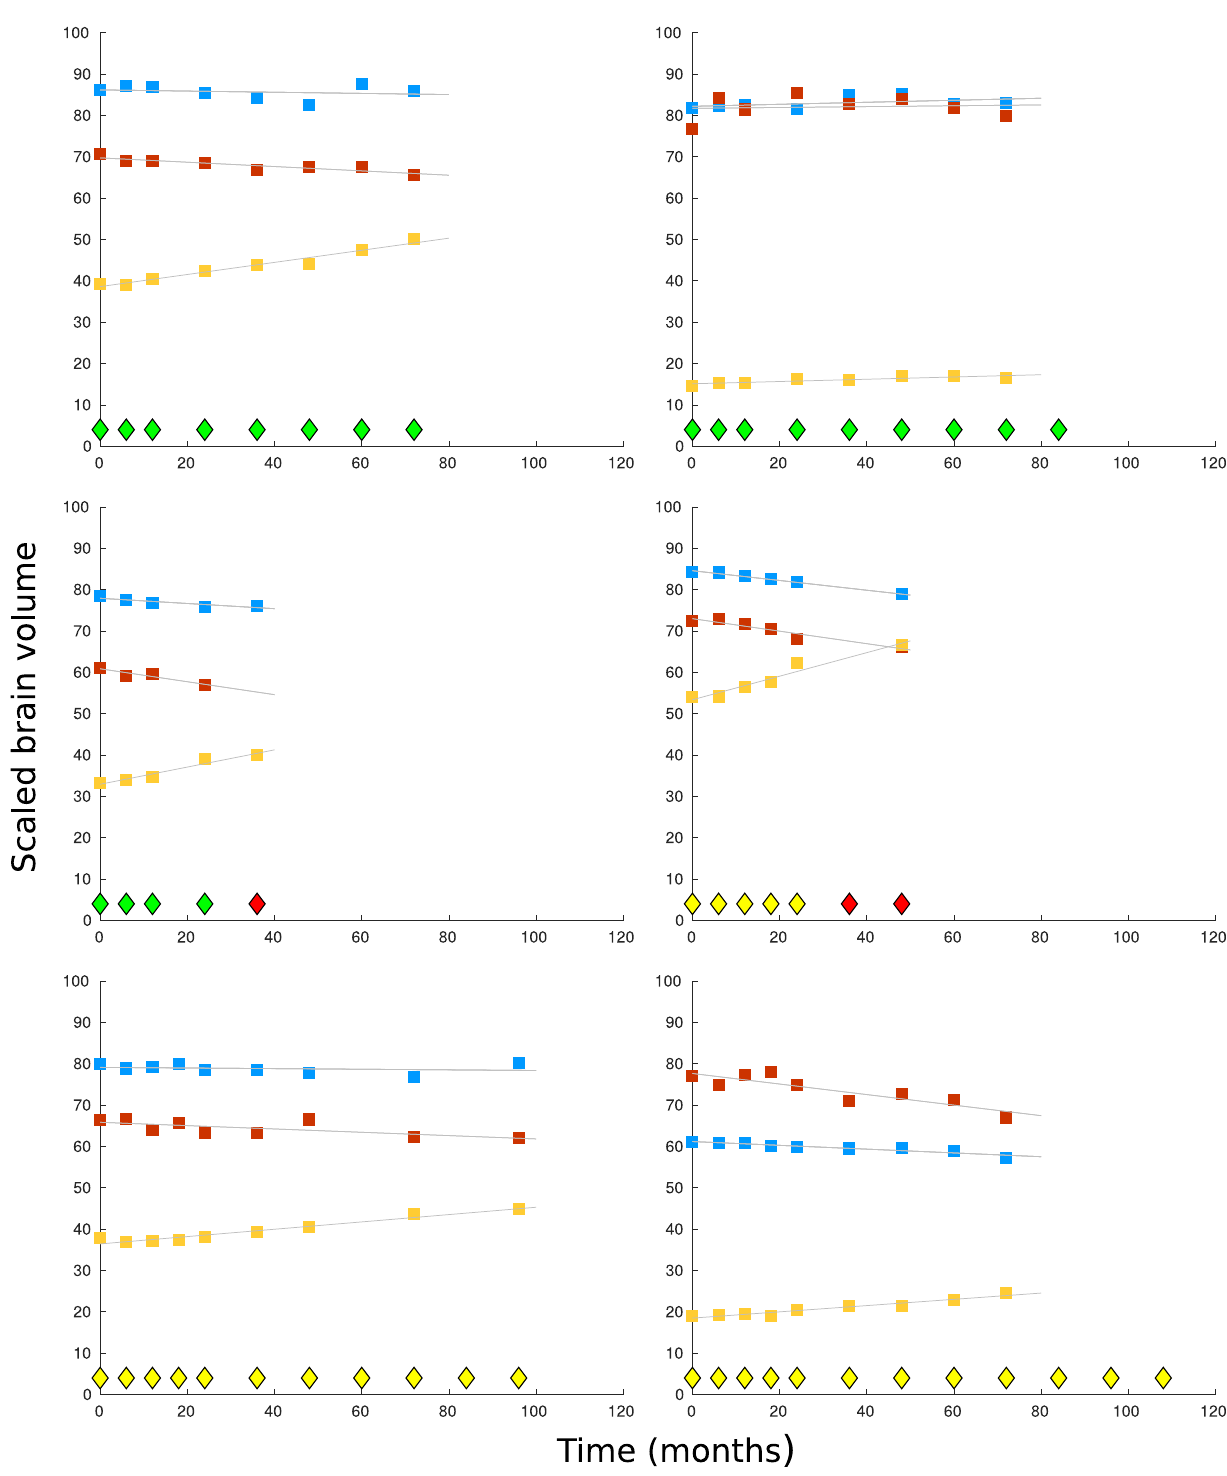
Fig 1. Sample plots by time (months) of scaled brain volumes for 6 participants. Diagnosis points are shown as diamonds at the base of each graph, with a healthy diagnosis shown in green, MCI in yellow, and Alzheimer’s disease in red. In the top two graphs, the participants have a healthy diagnosis throughout monitoring. In the middle two graphs the participants receive a diagnosis of Alzheimer’s disease 3 years after monitoring began. In the bottom the two graphs, the participants have a diagnosis of mild cognitive impairment throughout monitoring. The scaled brain volumes are shown in each graph from the top down as: whole brain (blue markers), hippocampus (red markers), and ventricles (yellow markers).